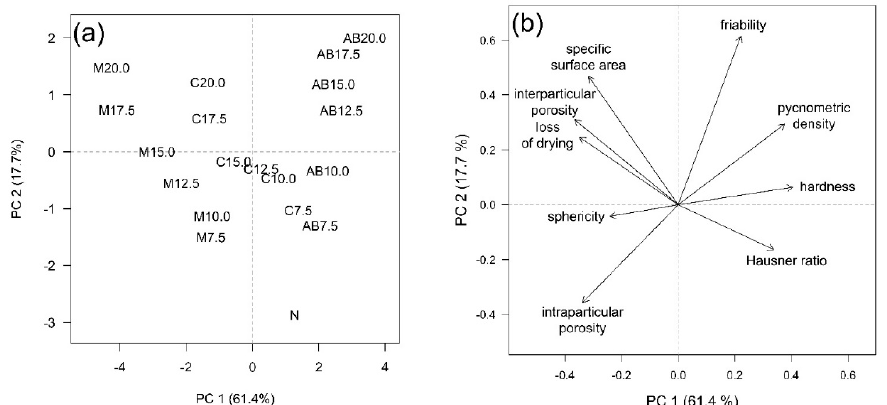
Figure 3. ( a ) PCA scores plot—objects included in the model: pellets differing in type and concen ‐ tration of the volatile substance. ( b ) PCA loadings plot—variables included in the model: selected pellet characteristics. Bulk and tapped density were excluded from the PCA due to the strong correlation of the respective vectors with the Hausner ratio vector.